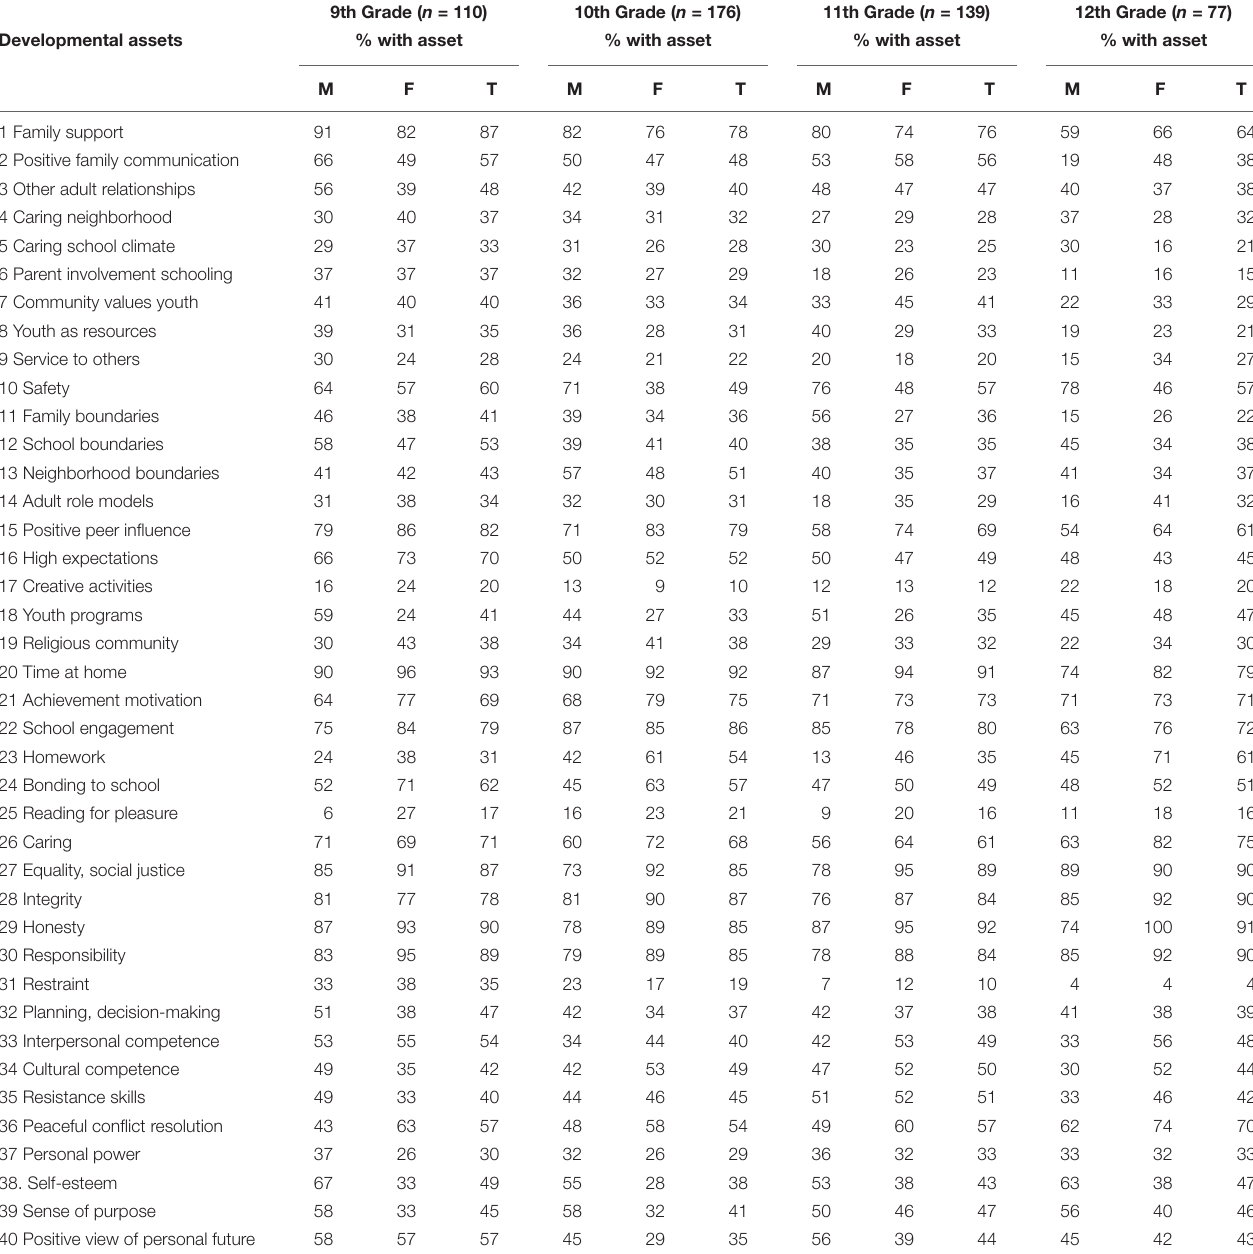
TABLE 2 | Experience of developmental assets by gender, grade, and total sample in